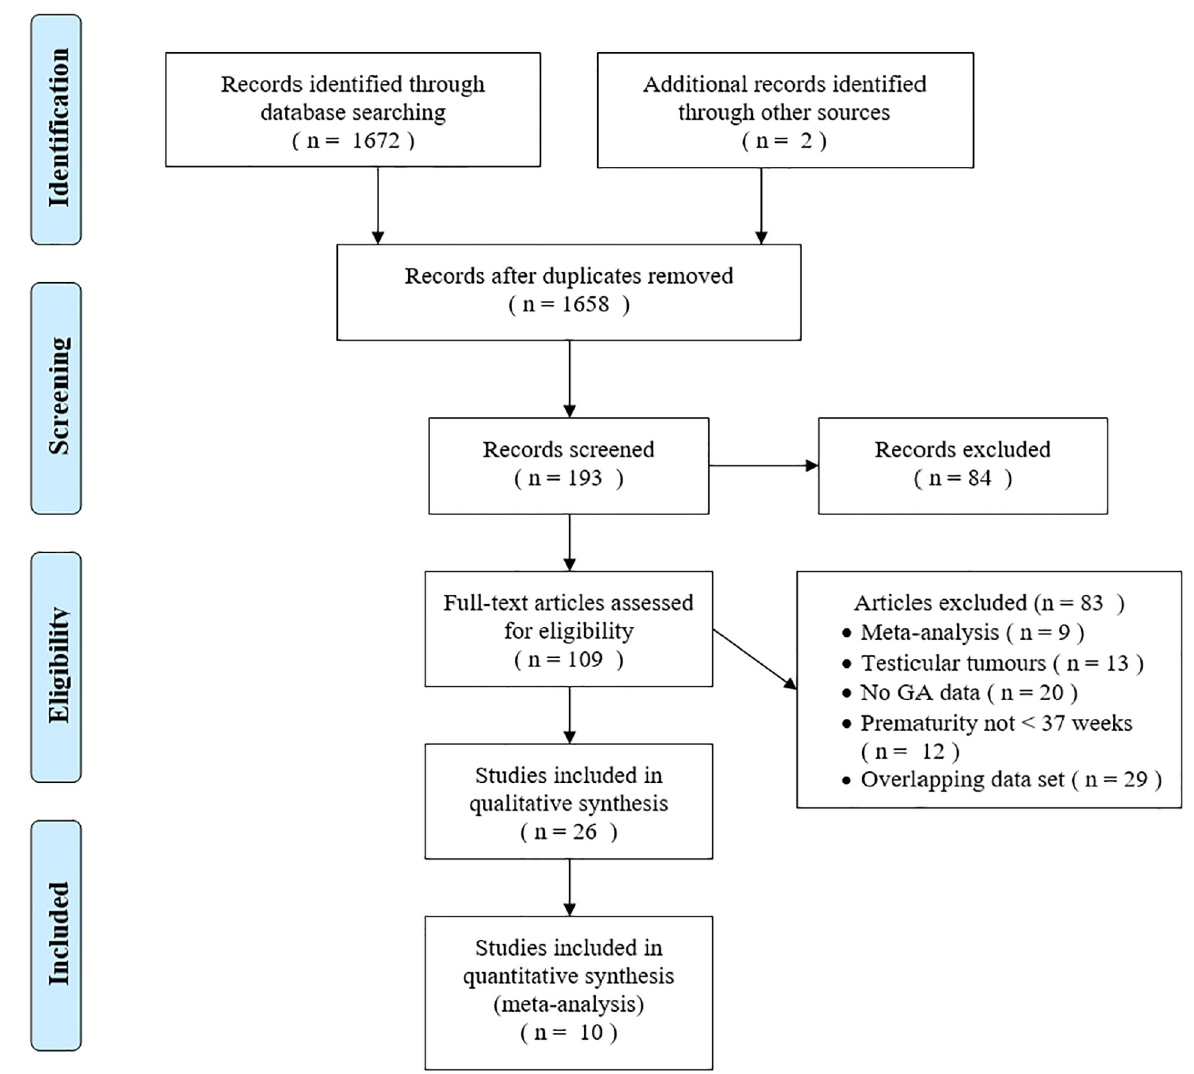
Fig 1. PRISMA flow diagram describing study selection